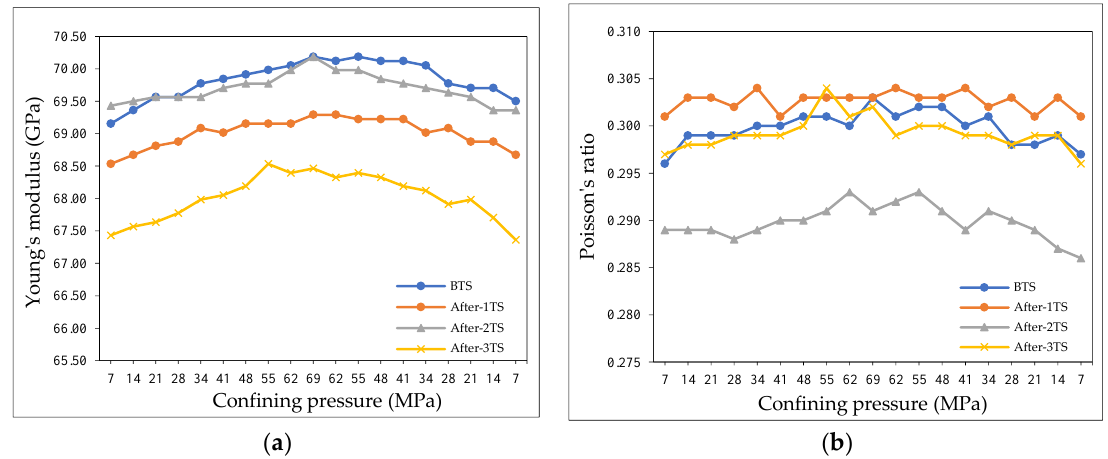
Figure 12. ( a ) Young’s modulus results of SH#5 at different confining pressures before and after thermal shock; and ( b ) Poisson’s ratio results of SH#5 at different confining pressures before and after thermal shock.